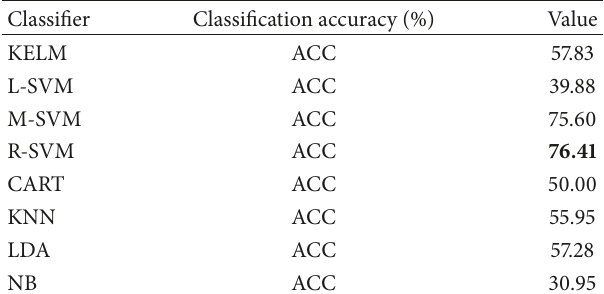
Table 6: Results of comparative classifiers without SAE on Istanbul